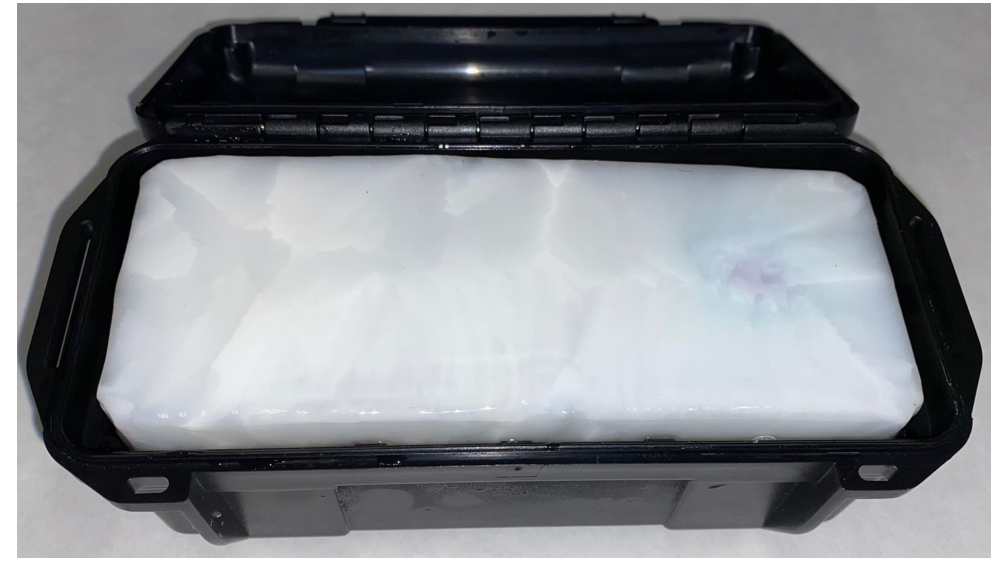
Figure 2. The fabricated phantom with embedded inclusions placed in the storage container. Dimen- sions: 165 mm × 75 mm × 50 mm (width × depth ×